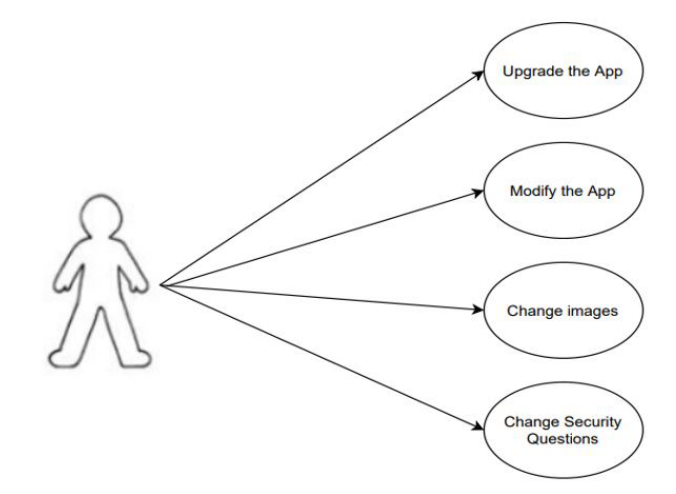
Figure 5. Use case diagram for